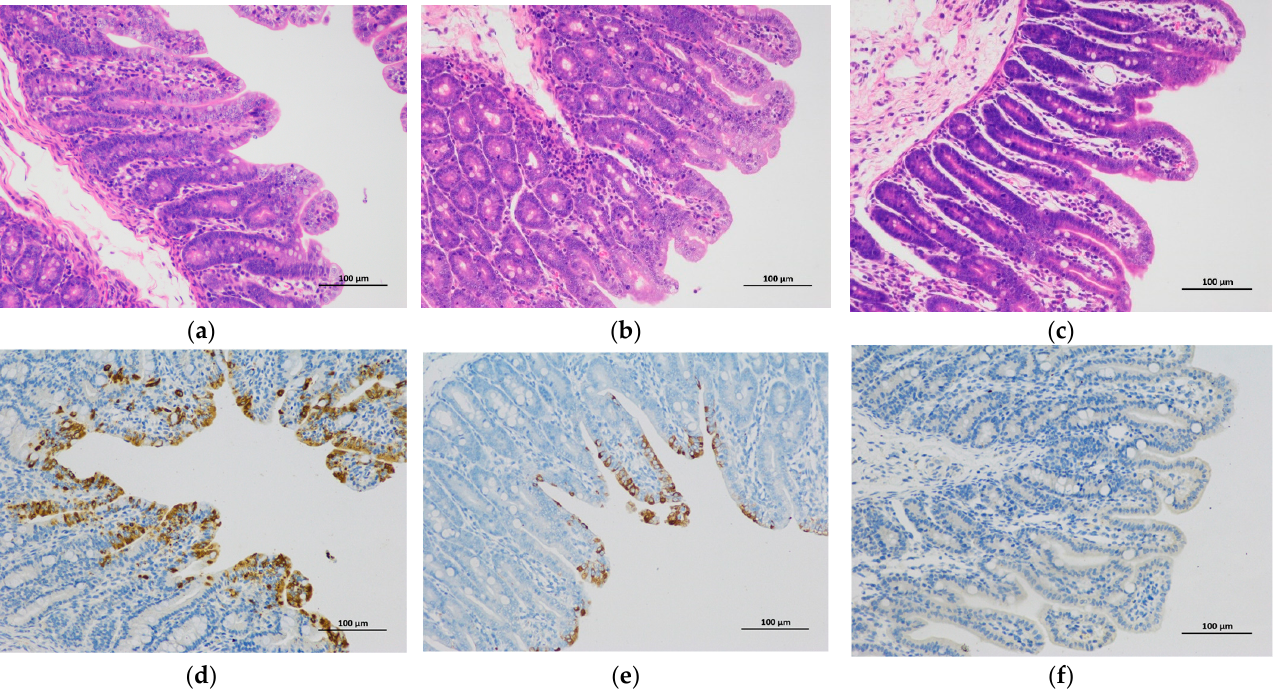
Figure 5. H&E and IHC staining of the jejunum from the PEDV-infected and mock piglets. Different tissue samples including the duodenum, jejunum, ileum, cecum, MLNs and stomach from each group were taken and then processed for H&E and IHC staining, and representative images of the jejunum are shown (200×). H&E staining of the jejunum in piglets from the ( a ) 17GXCZ-1ORF3d, ( b ) 17GXCZ-1ORF3c and ( c ) mock groups. The jejunum from the PEDV-infected piglets was characterized by the shortening, atrophy or even the shedding of intestinal villus. IHC staining of the jejunum from the ( d ) 17GXCZ-1ORF3d, ( e ) 17GXCZ-1ORF3c and ( f ) mock groups. PEDV antigen appears as a brown stain and was detected in the epithelial cells of the jejunum in 17GXCZ-1ORF3d and 17GXCZ-1ORF3c infected piglets. The intestinal tissue sections were stained with an anti-PEDV spike protein monoclonal antibody followed by the incubation with an HRP conjugated goat anti-mouse antibody and then visualized using a fluorescent microscope.